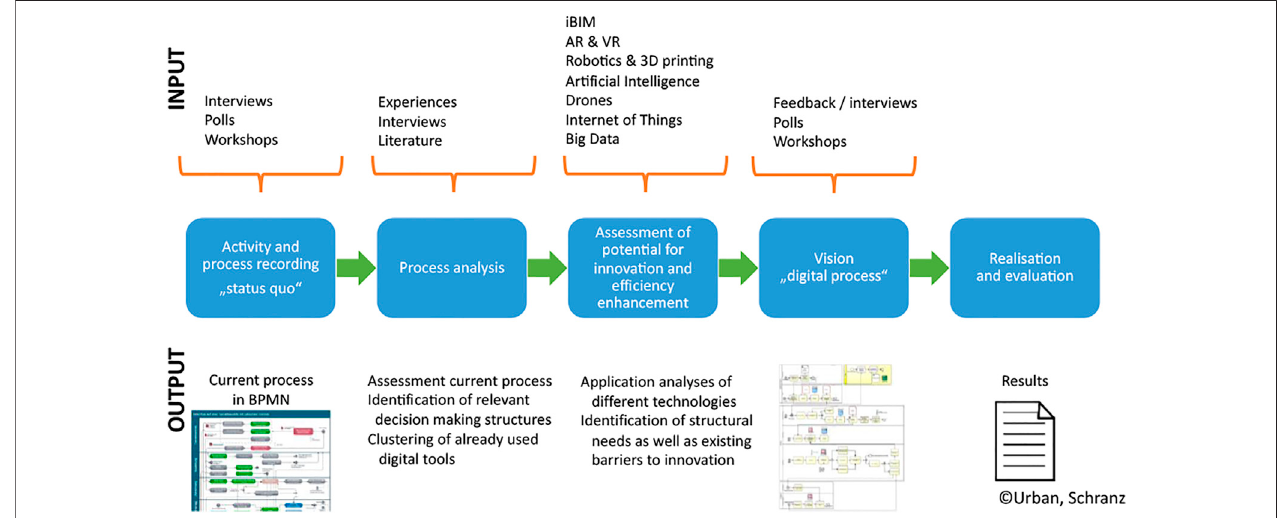
FIGURE 4 | Process to implement Construction 4.0 (based on Goger et al. (2017)).